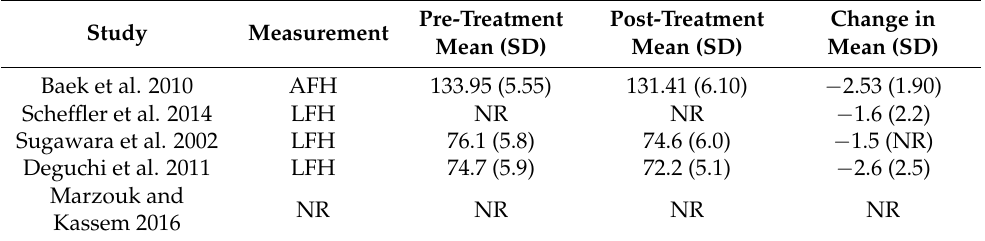
Table 9. The change in anterior facial height or lower facial height as a result of anterior open bite treatment by molar intrusion using skeletal anchorage (mm).